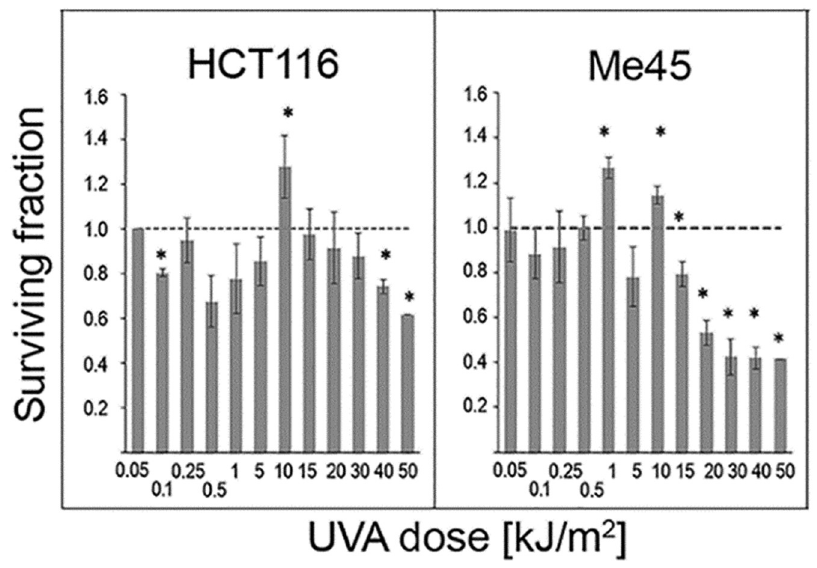
Fig 1. Clonogenicity of human cells after exposure to different UVA doses. (A) HCT116 cells, (B) Me45 cells. Data show the mean and SD of 3 experiments. Asterisks denote statistical significance of differences between irradiated and control samples with a p-value < 0.05. The horizontal dashed line represents the control level.